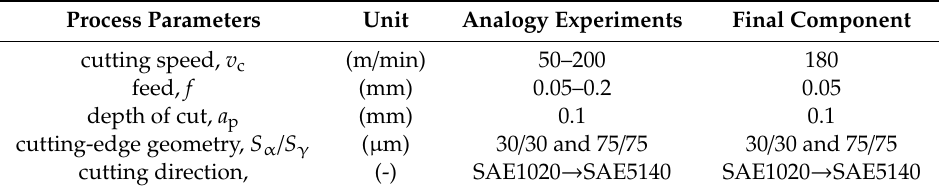
Table 1. Process parameters of the cutting operation.